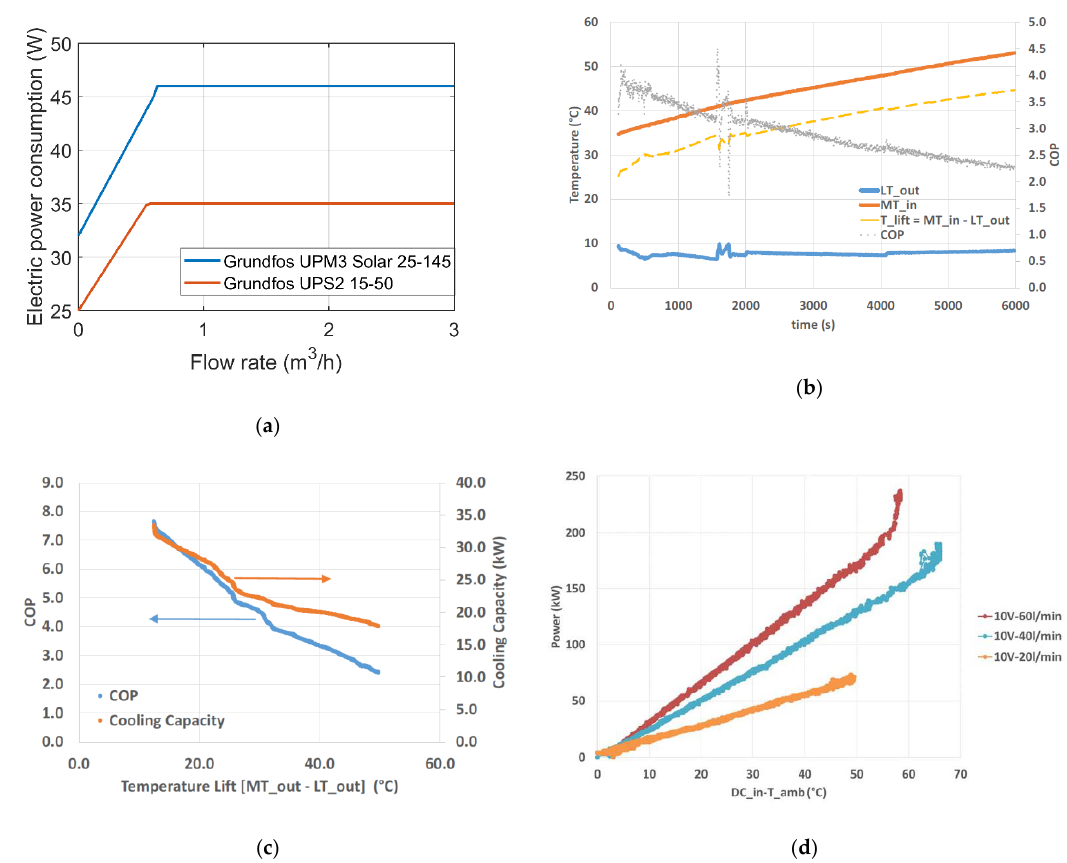
Figure 5. Experimental results of ( a ) the electrical consumption of the pumps, as well as the developed backup heat pump performance; ( b ) at maximum flow rate; ( c ) as a function of the maximum temperature lift and ( d ) cooling map of the dry cooler for variable flow rates at maximum fan speed. Regarding the performance of the backup heat pump, its COP is defined by Equation (5).